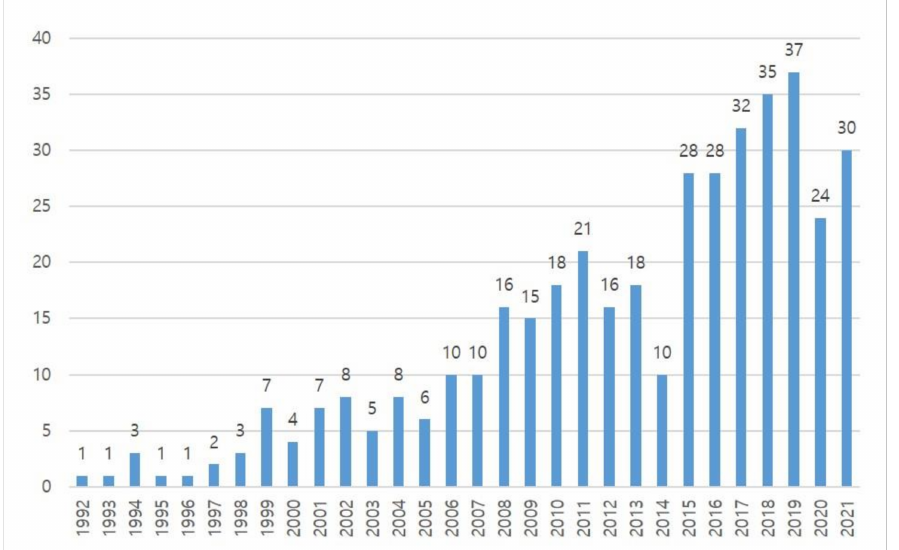
Figure 2. Number of articles published per year (1992–2021).